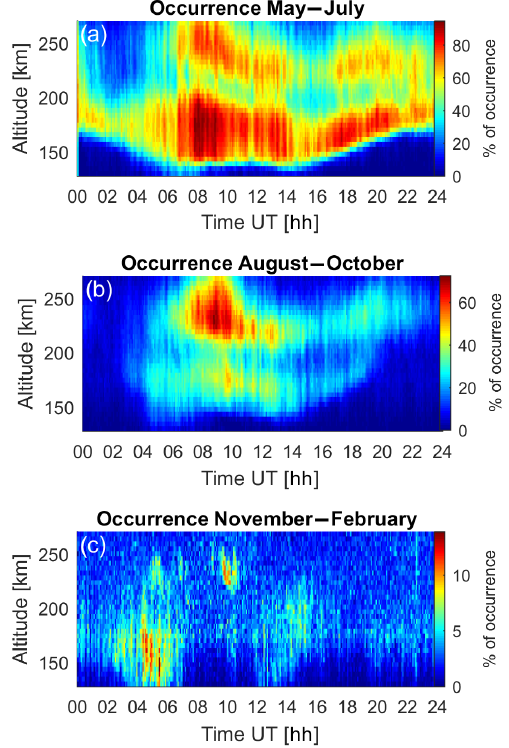
Figure 2. Occurrence of detected plasma line backscatter with 30s integration: (a) May to July 2007; (b) August to October 2007; (c) November 2007 to February 2008. Magnetic local time at ESR is UT +